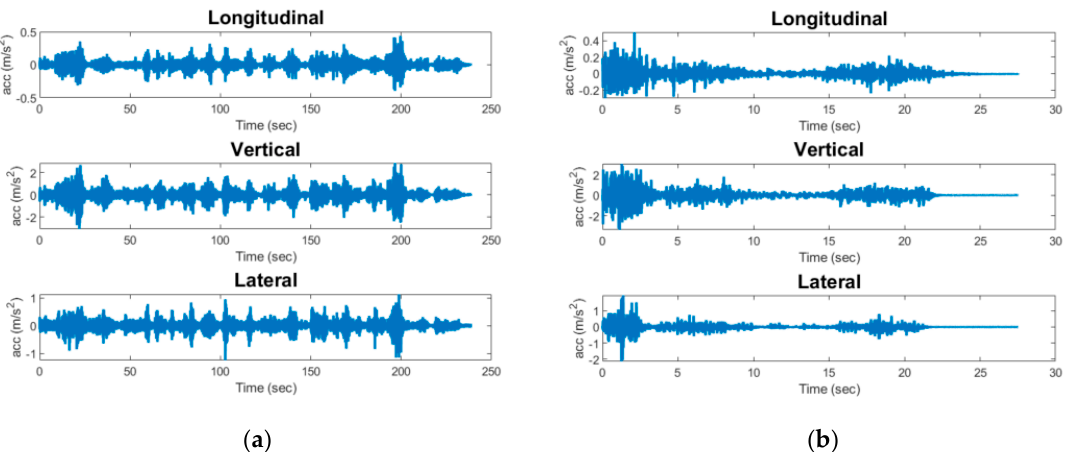
Figure 4. Sample data collected using the Xnode for a train crossing of a short rail bridge over a highway: ( a ) freight train; ( b ) passenger train.